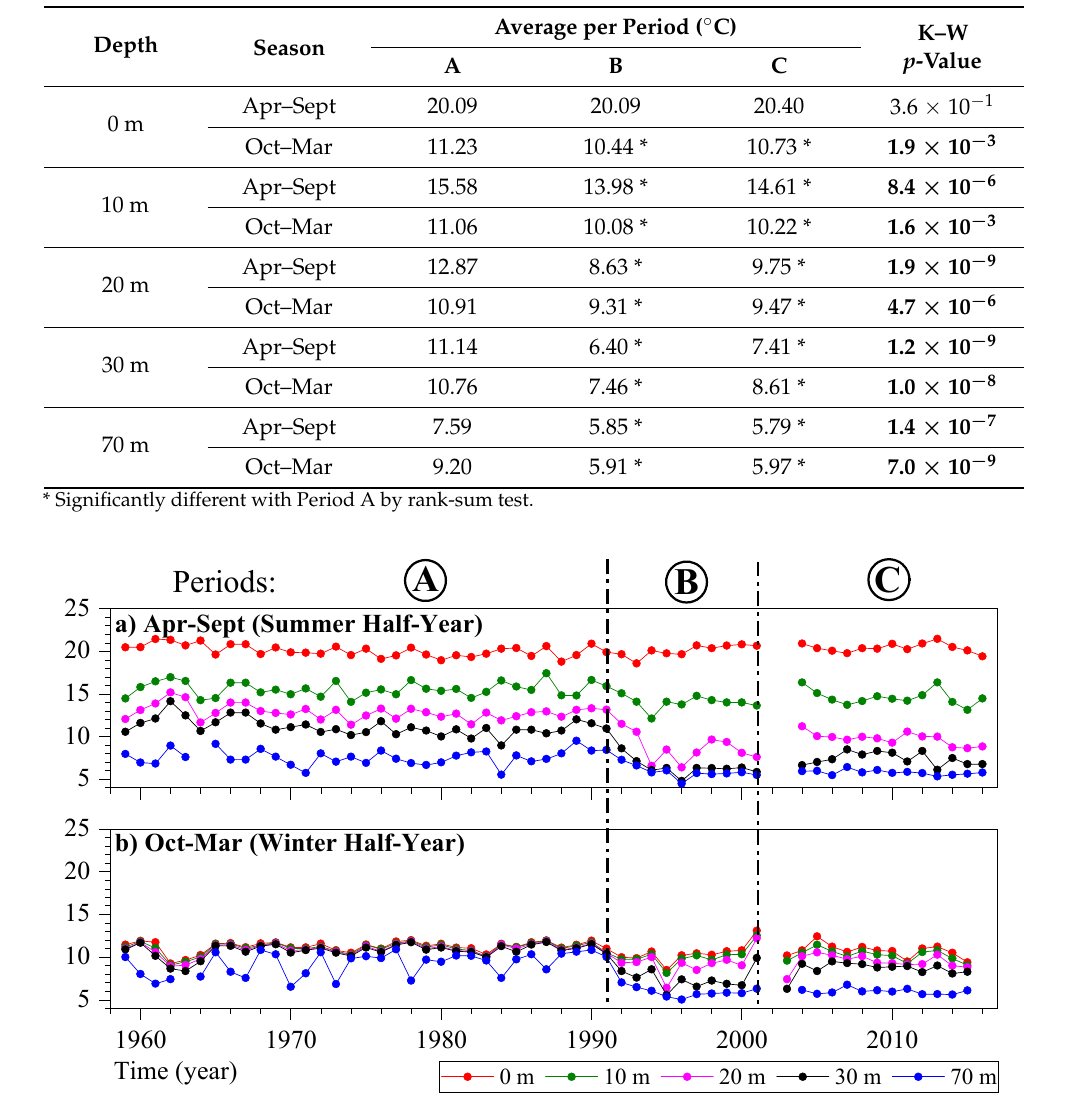
Figure 6. Average annual water temperatures at different depths from 1959 to 2016 for ( a ) the summer half-year and ( b ) the winter half-year.